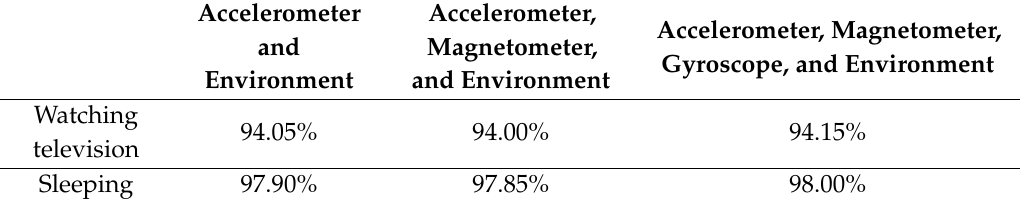
Table 21. Accuracies of the activities’ recognition without motion using the DNN method for motion and magnetic sensors after the recognition of the